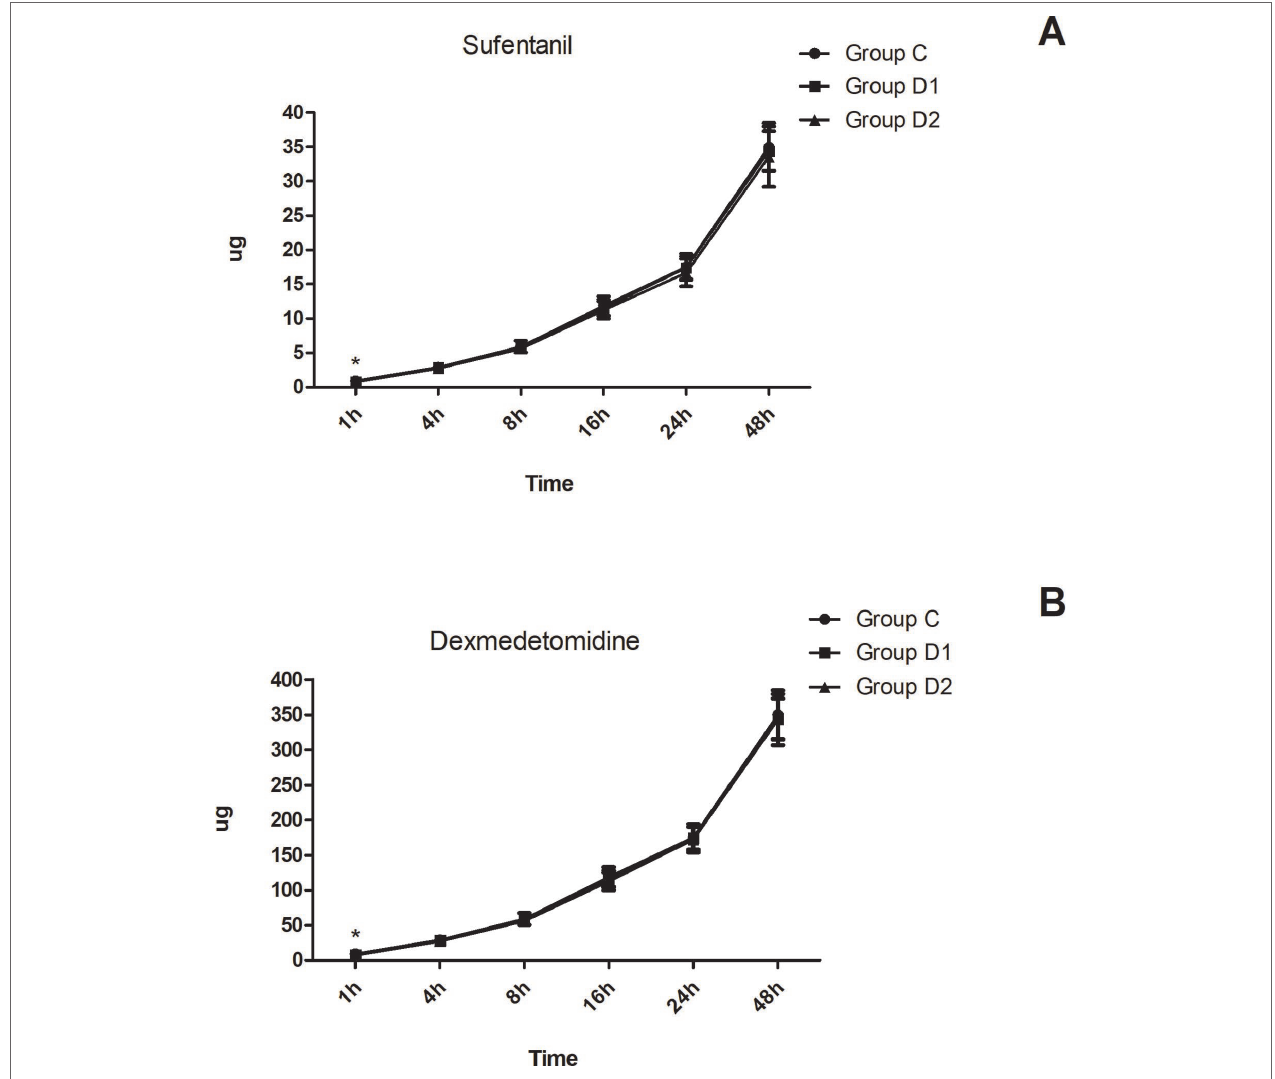
FIGURE 4 | Postoperative consumption of sufentanil and dexmedetomidine in the three groups. (A) Postoperative consumption of sufentanil in the three groups at different time-points. (B) Postoperative consumption of dexmedetomidine in the three groups at different time-points. * P < 0.05 vs. group